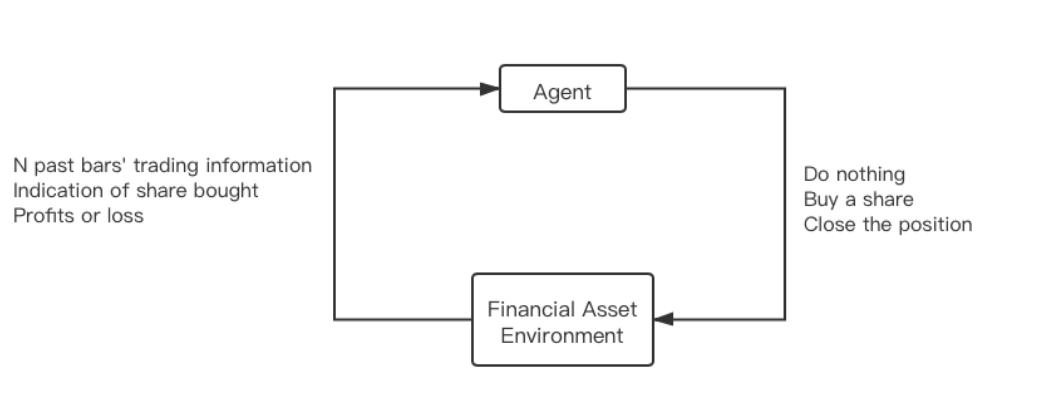
Figure 2. Interaction between environment and